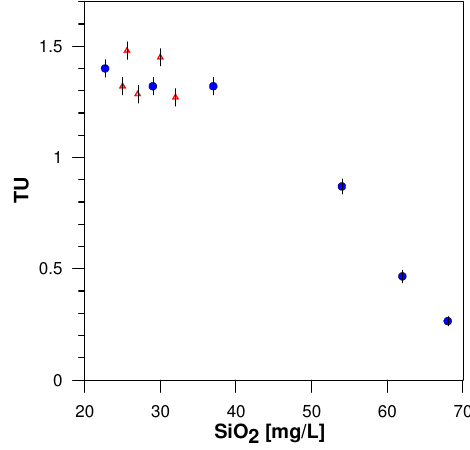
Fig. 6. Tritium versus SiO 2 concentration. Explanation of symbols see Fig. Figure 6. Tritium versus SiO 2 concentration. 5